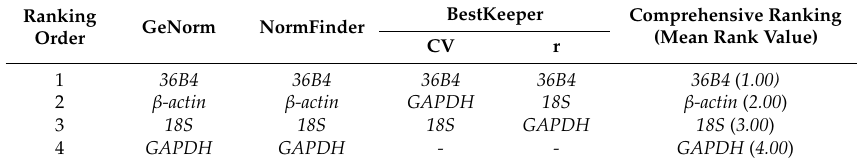
Table 5. Comprehensive ranking (iBeAT).